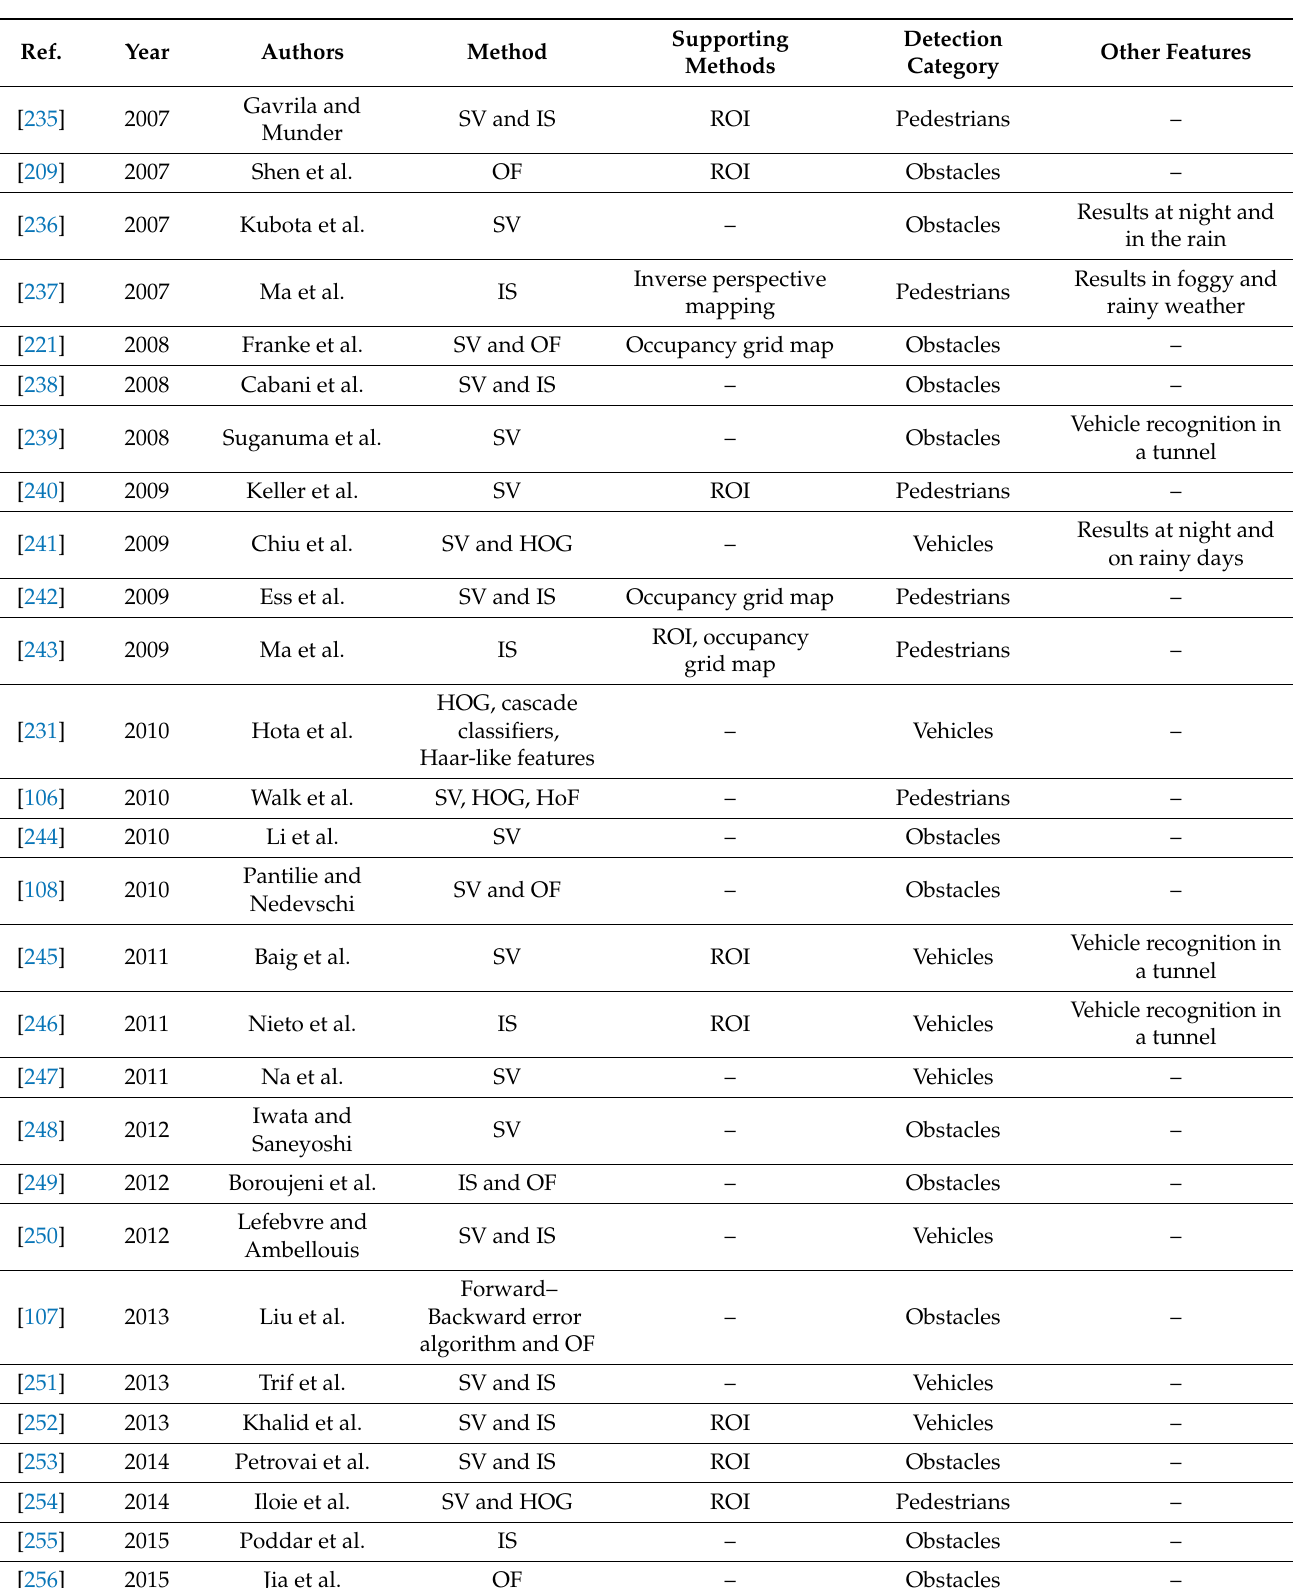
Table 8. Obstacle Detection Studies with CV